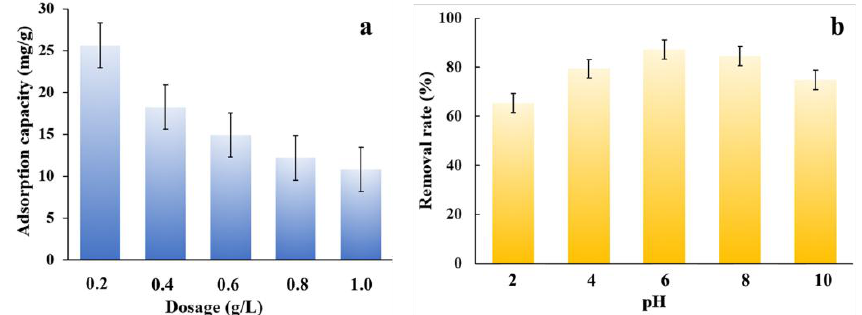
Figure 8. ( a ) Plots of adsorption capacity vs dosage; and ( b ) plots of removal rates vs. pH value with a dosage of 0.8 g L −1 . All the curves were obtained in a 10 mg L −1 NOR aqueous solution at 30 °C.